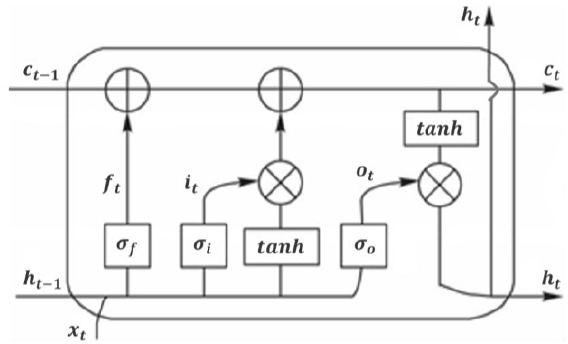
Figure 3. Structural diagram of an LSTM cell.